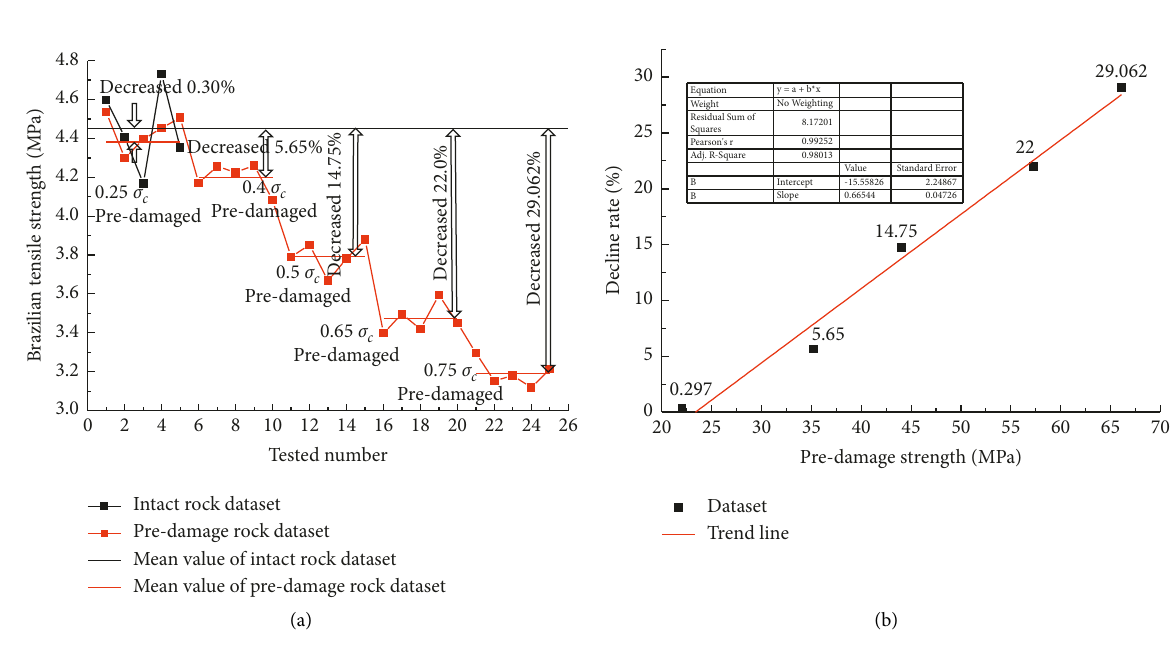
Figure 7: BTS test results and reduction rate